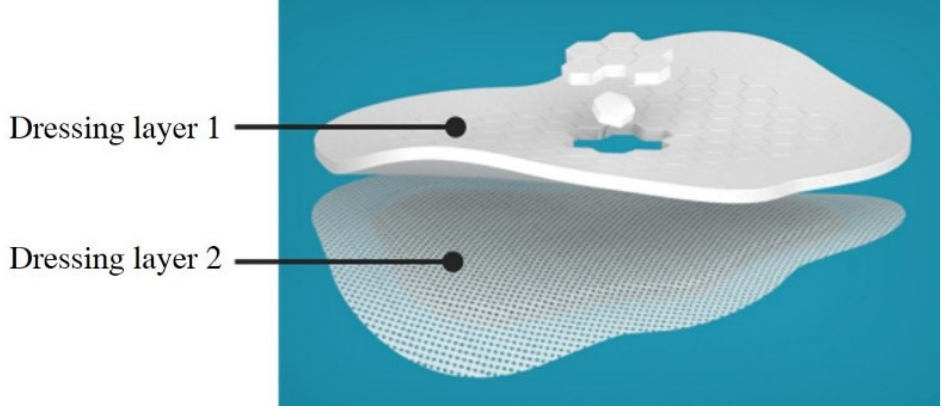
Figure 1. The new dressing design developed by Urgo RID. The dressing layers were tied together. Tie constraints were also used between the soft tissue layers and between the skin and dressing layer 2. A coefficient of friction of 0.62 was defined between dressing layer 2 and the mattress. This value was computed from friction tests performed at Urgo RID. The dressing, glued on a calibrated weight, was positioned on a rigid plate cover with a clinical sheet. A gradually increasing force was applied to a cable attached to the dressing. The coefficient of friction was the ratio of the force that pulled the dressing and the calibrated weight. Between the skin and the mattress, this coefficient was set to 0.43 [20]. A vertical force of 217 N was applied to the pilot node of the sacrum area, as illustrated in Figure 2a. Considering the symmetry of the model, this corresponded to 47% of the bodyweight of a 94 kg subject [21]. The bottom nodes of the mattress were fixed in position. Simulations were performed with ANSYS in a quasi-static analysis with an implicit scheme. Soft tissues were modelled with non-linear hyperelastic isotropic constitutive equa- tions. More particularly, the skin was modelled with the law proposed by Isihara et al. [22]. The material parameters were optimised using a curve-fitting method from the data of Ni Annaidh et al. [23]. The adipose tissues were modelled with the equation developed by Yeoh [24] with parameters fitted according to the data of Sommer et al. [25]. The soft tissue stiffness was increased close to the wound region, as detailed in Fougeron et al. [11], to account for the stiffening of the tissues surrounding a PU. The constitutive equation for the different tissues